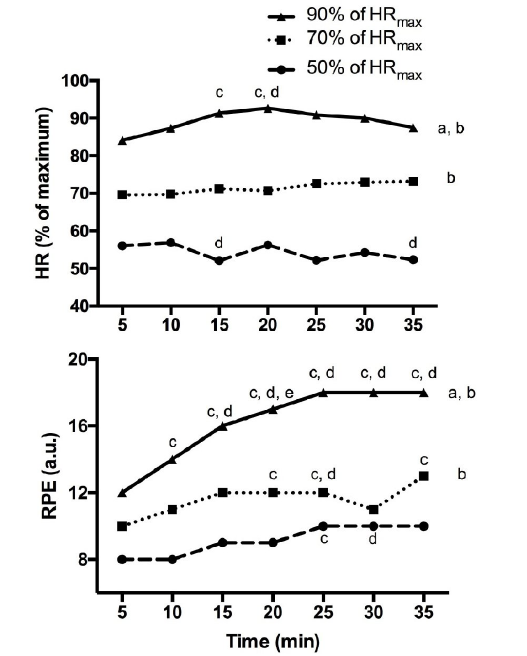
Figure 1. Mean and standard deviation of heart rate (HR) (upper panel) and rating of perceived exertion (RPE) (lower panel) at different instants during different compounding circuit training sessions based on maxi- mum HR. For both HR and RPE variables: 90% of HR tensity was significantly different from 70% and 50% of HR intensities at iso-time (same instant) for the whole session; 70% of HR exercise intensity was significantly different from 50% of HR intensity at isotime for the whole session. a Significantly different from 5 min at the same intensity; b Significantly different from 10 min at the same intensity. c Significantly different from 15 min at the same